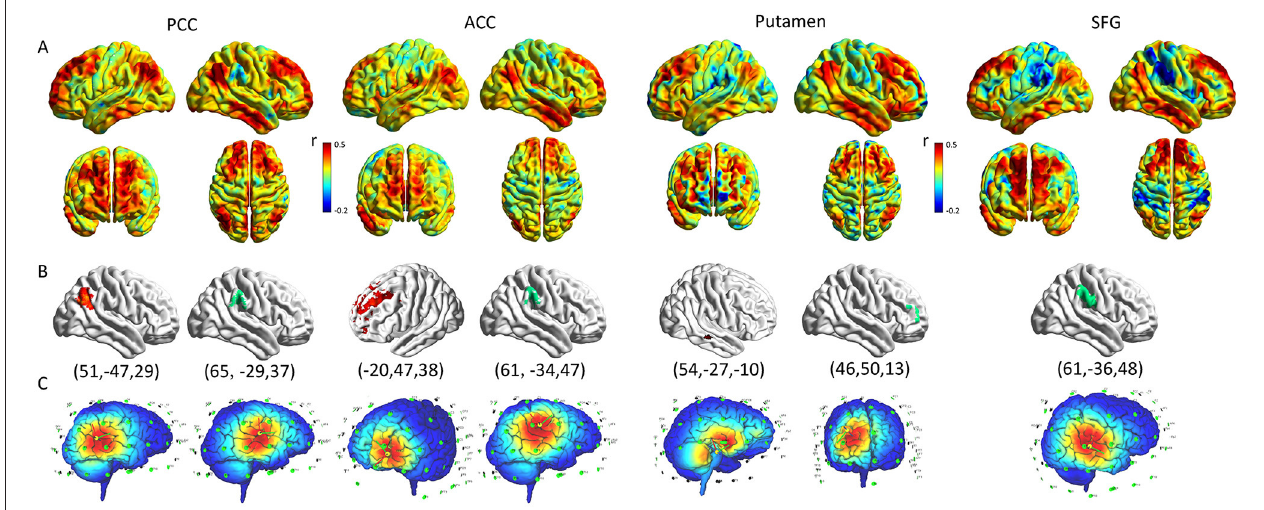
FIGURE 5 | Optimization of rTMS for cortical functional connectivity pattern. (A) The pattern map of the connection between ROIs and whole brain. (B) The cluster with the maximum correlation coefficient with ROI in the cortex (Red represents positive correlation, green represents negative correlation; The peak coordinates are shown below the graph). (C) The rTMS treatment coordinates according to the functional connection pattern diagram (The target of activated rTMS therapy was the cluster which had a positive correlation coefficient with the ROIs, the target of inhibited rTMS therapy was the cluster which had a negative correlation coefficient with the ROIs). rTMS, repetitive transcranial magnetic stimulation; ROI, region of interest; PCC, posterior cingulate cortex; ACC, anterior cingulate cortex; SFG, superior frontal